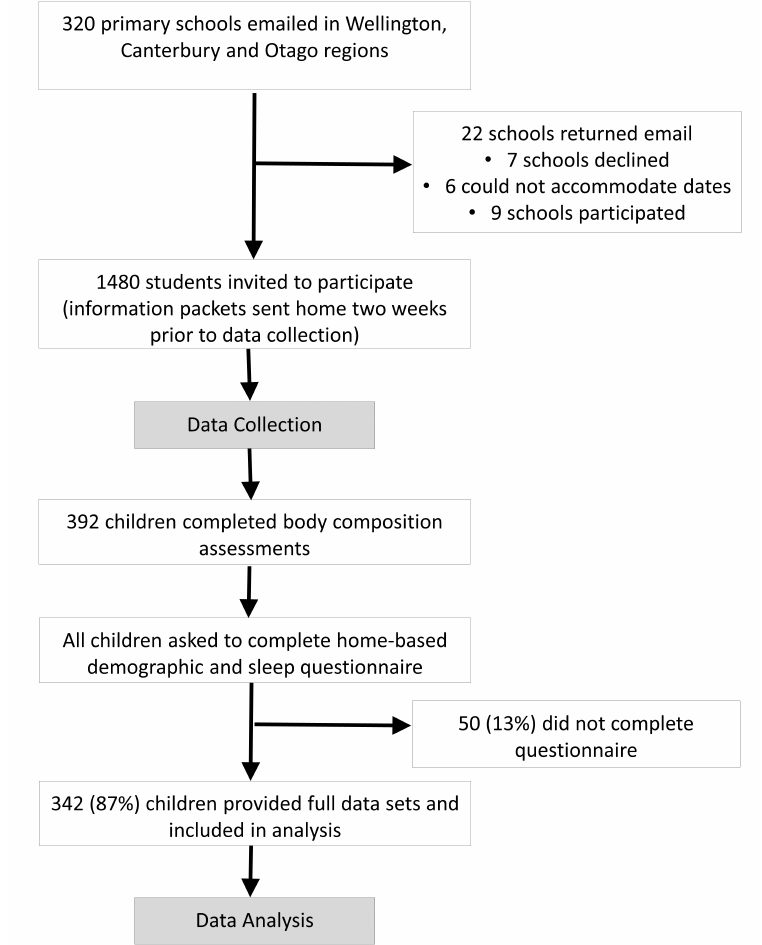
Figure 1. Participant recruitment